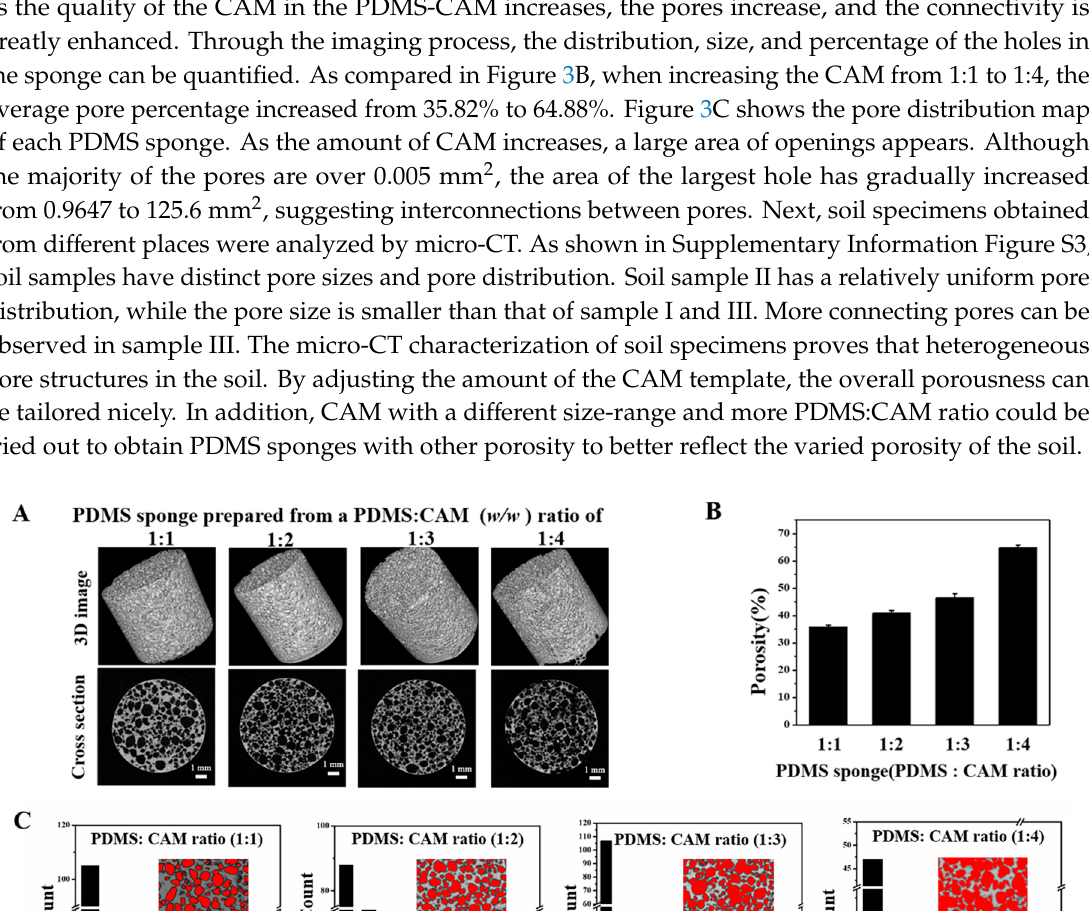
Figure 4. Water content of PDMS sponges. ( A ) The maximum water content of PDMS sponges. ( B ) Void ratio of PDMS sponges. 3.3. Plant Growth on Hydrophilic Porous PDMS Sponge The seed development on the porous PDMS sponges was recorded. As shown in Figure 5A, coleoptiles were observed sprouting out from the O. sativa seeds after 2-day incubation. On the third day, roots grew and extended into the porous PDMS sponge, which was prepared from a PDMS:CAM ratio of 1:4. O. sativa roots were observed penetrating PDMS sponge − 1:3 and PDMS sponge − 1:2 on day 4. It took five days for O. sativa seeds to grow into PDMS sponge − 1:1. When the cultivation time was prolonged to 7 days, roots could be observed from the bottom side of the PDMS